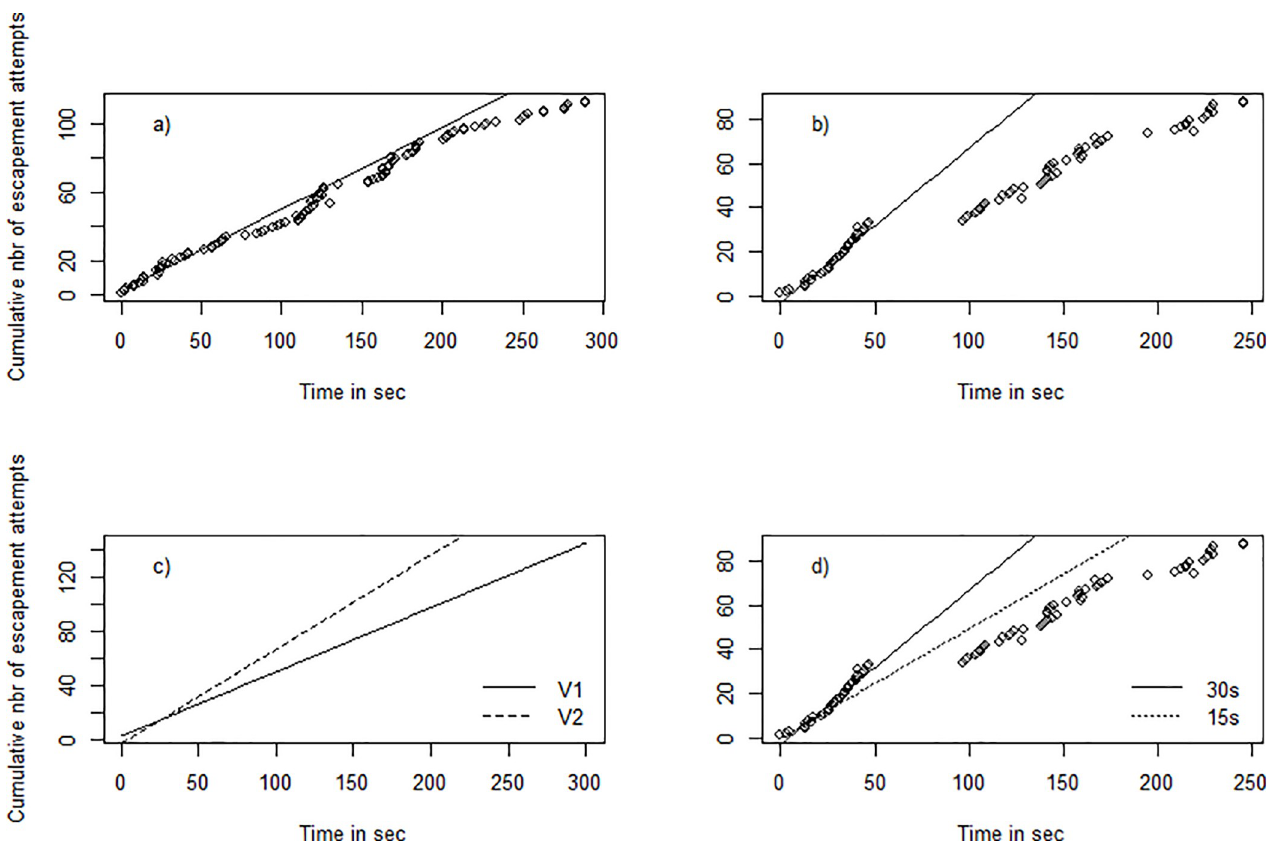
Fig 6. Cumulative number of escapement attempts through time (5 minutes) in video 1 (a) and video 2 (b) taken after an interval of 50 minutes (after 10 minutes and 1 h of towing, respectively). Solid lines represent linear regressions fitted on the first 30 s of observation of each video footage. Panel c) describes the linear regression adjusted on the first 30 s of videos 1 and 2. Panel d) illustrates the linear regression adjusted on the first 15 or 30 s of video 2.